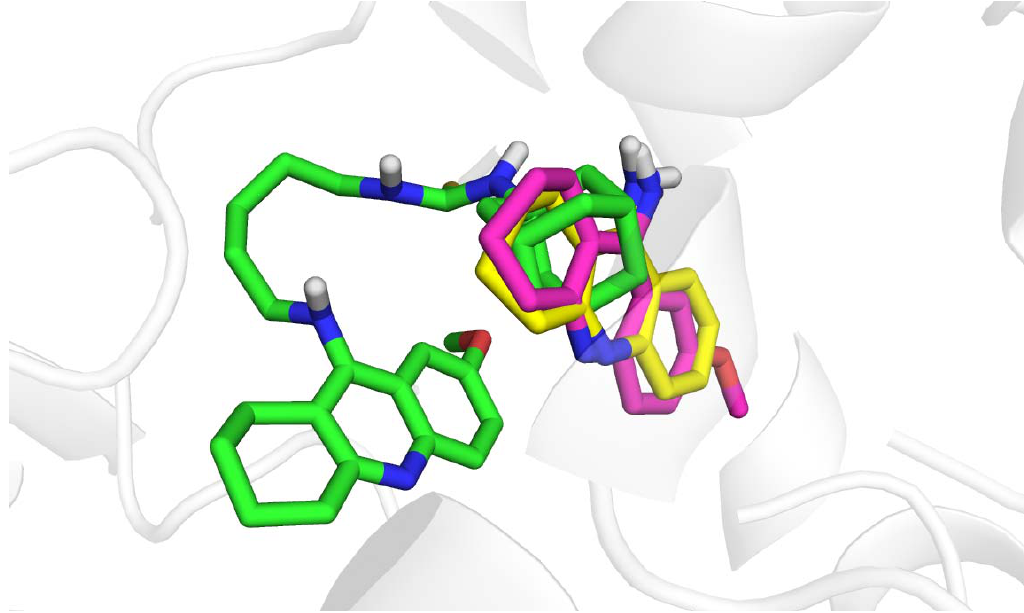
Figure 7. Top-scored docking poses representation within hBChE active site for 14 (green), THA (yellow) and 7-MEOTA